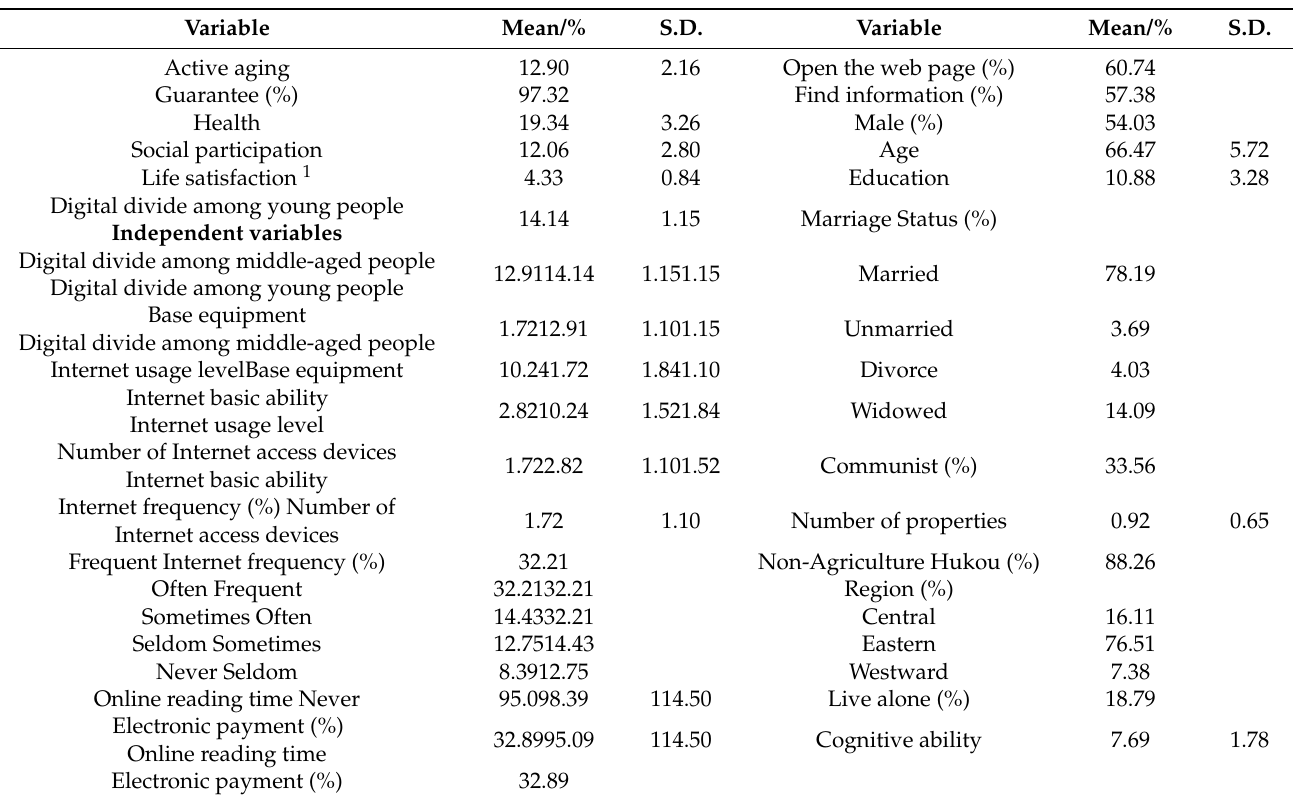
Table 1. The basic situation of the